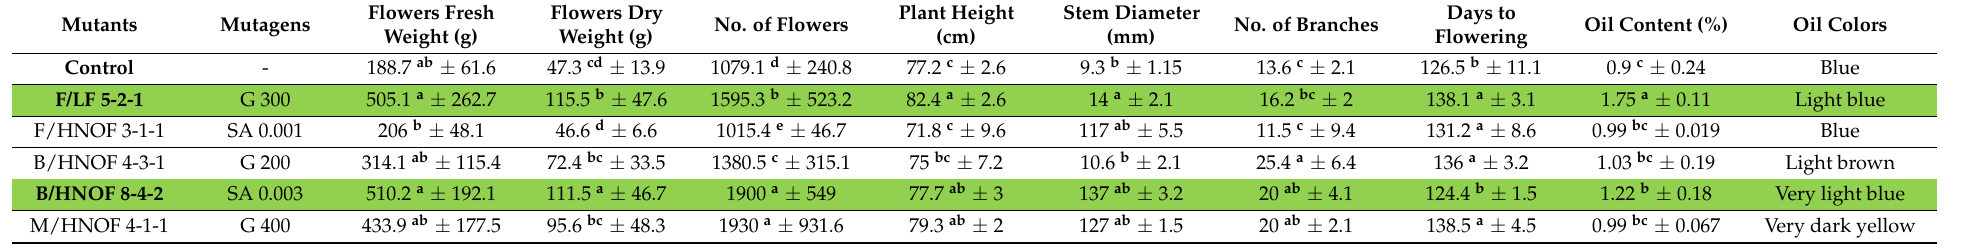
Table 3. Mean performance of morphological features, oil content and oil colors for the selected five M 4 promising mutants of German chamomile populations.